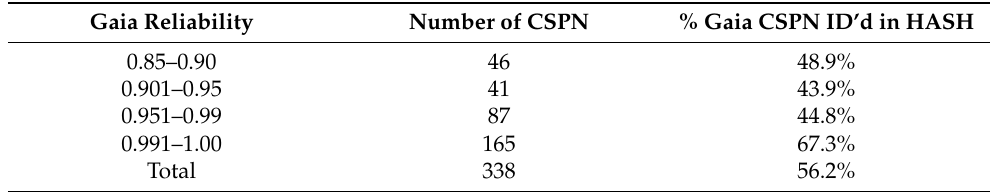
Figure 3. ( Left ): SDSS irg color RGB annotated image of PN Ou 2. ( Right ): IPHAS H α /R band quotient image of Ou 2 that shows the round 90” diameter PN and the true CSPN location. Table 2. Comparison between 338 (~1/3rd random sample) of the 904 raw Gaia CSPN candidates with putative reliabilities >0.85 and what HASH reveals. We believe that many Gaia CSPN identifications need to be re-examined, though the EDR3 comparison will be better (in preparation).